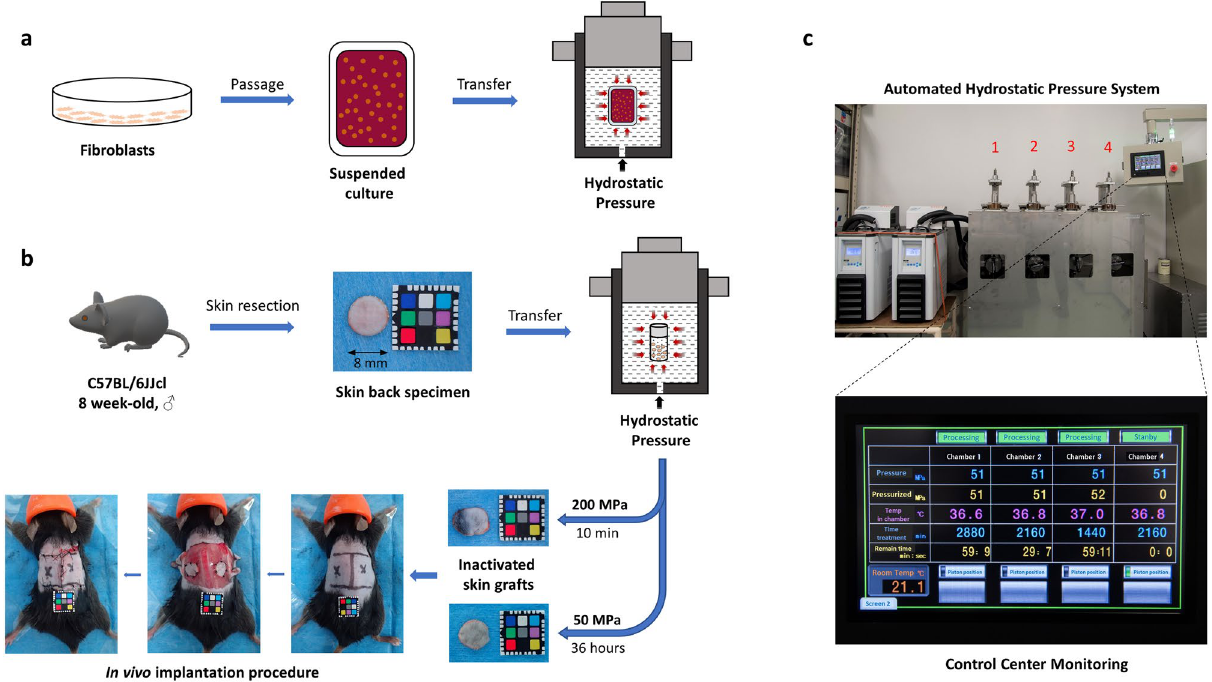
Figure 1. Schematic description of the pressurization process. ( a ) Preparation of suspended culture fibroblasts in a plastic bag and the induction of hydrostatic pressure inside the isostatic chamber. ( b ) Procedures for inactivating skin tissues by HHP and subcutaneous transplantation onto the backs of mice. A 1 cm × 1 cm color chart was used as a scale bar. ( c ) The new custom HHP device, comprising a temperature management system, four separate isostatic chambers for input objects (No. 1–4) and an automated touch screen control